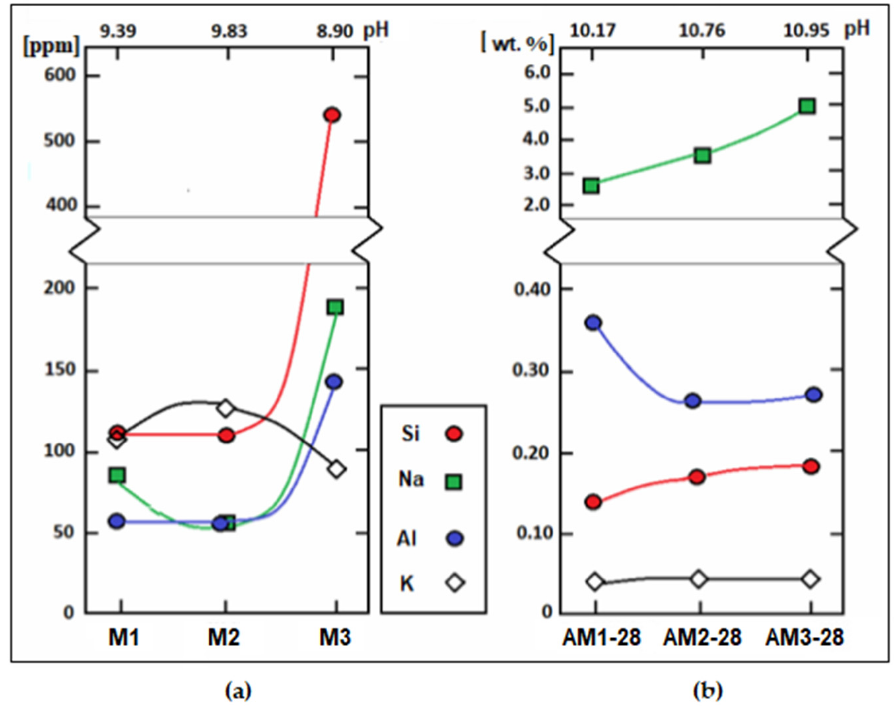
Figure 6. Relation between the elements in distilled water leached from ( a ) metakaolins (M) and ( b ) alkali activated AM-28.